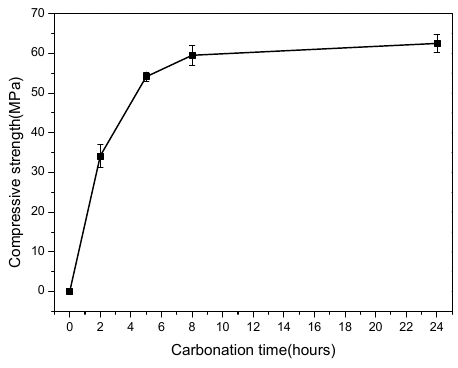
Figure 1. The compressive strength of compacted C 3 S 2 samples with different carbonation times.